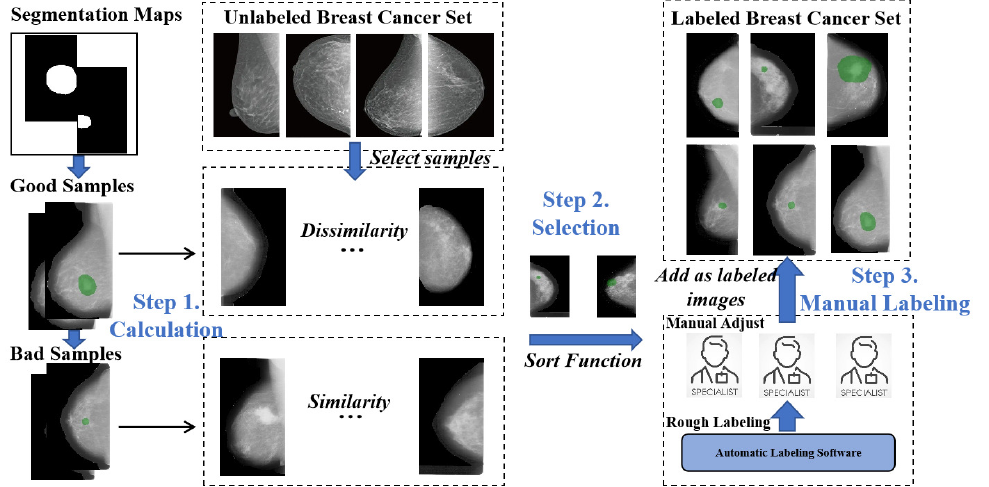
Figure 2. Key steps, i.e., Calculation, Selection, and Manual Labeling, in the proposed active-learning- based labeling